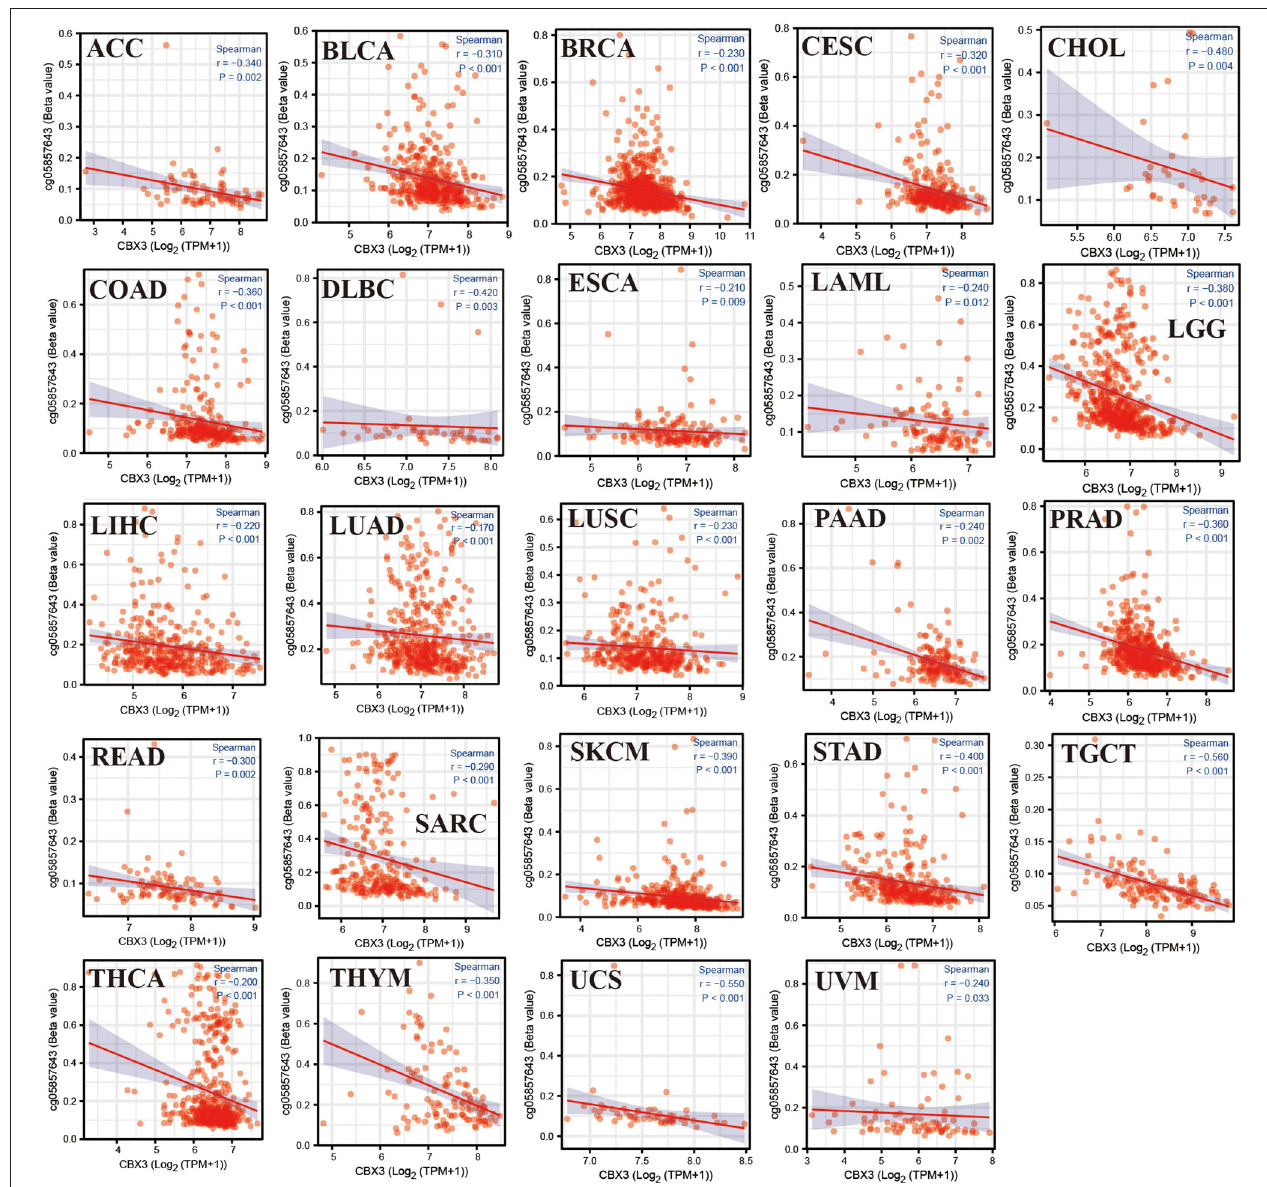
FIGURE 12 | Association between CBX3 expression and promoter methylation of various tumor